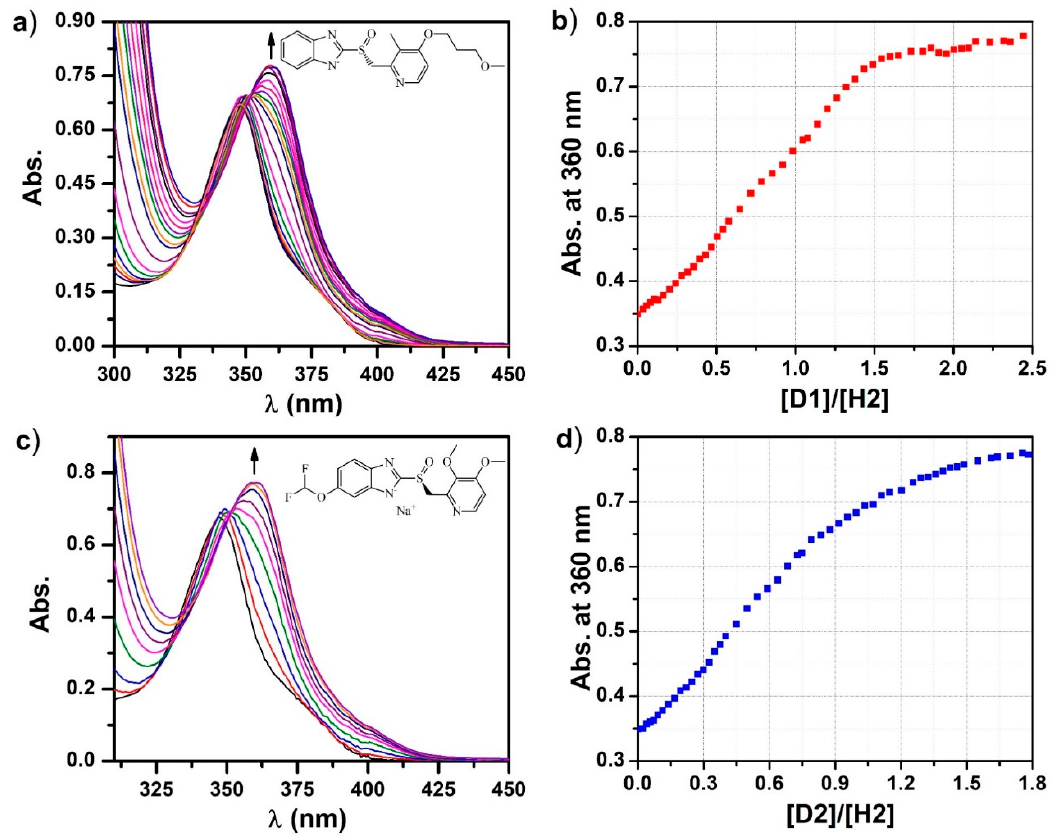
Figure 4. UV-Vis spectra of host H2 upon titration with ( a ) D1 and ( c ) D2 , and plots of ( b ) D1 / H2 and ( d ) D2 / H2 molar ratio vs. absorbance at 360 nm based on the titration experiment.